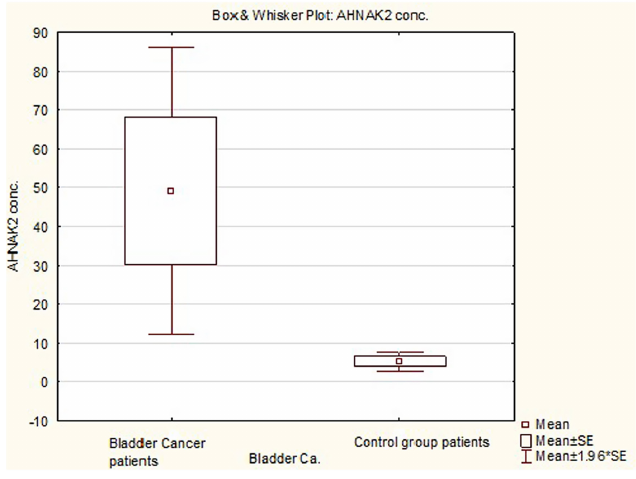
Figure 1. Boxplot showing AHNAK2 urinary levels in the bladder cancer group and control group.